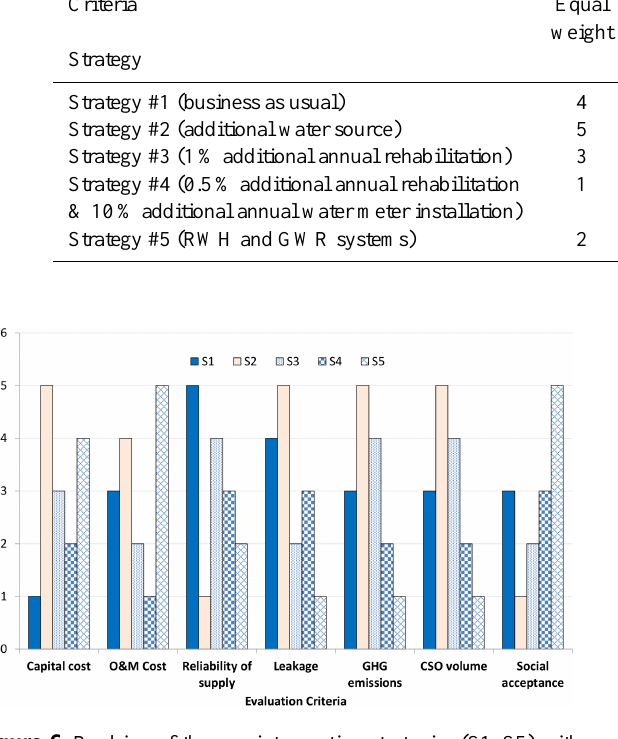
needed to consider different scenarios and risk-based criteria in order to achieve a robust solution in the